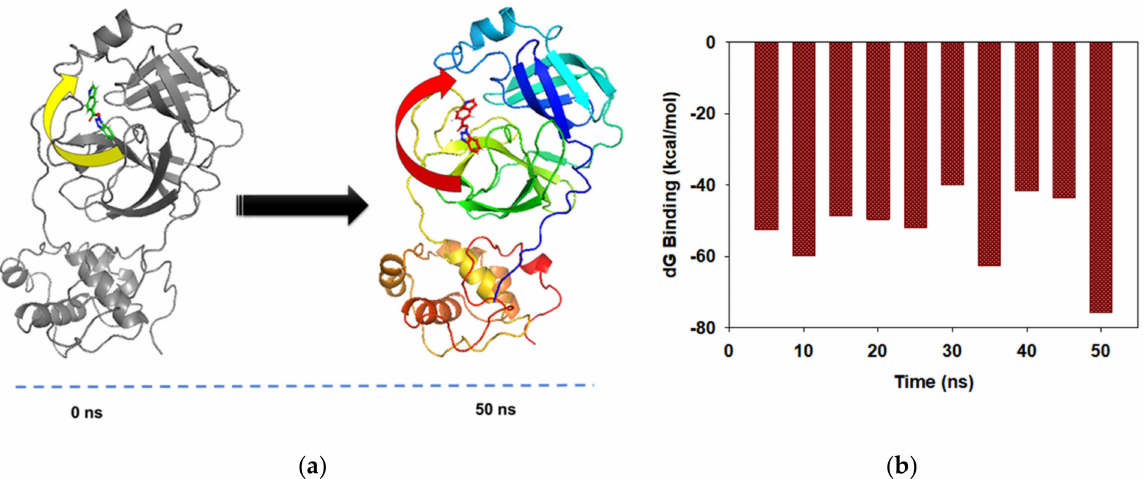
Figure 5. ( a ) Structural superimposition of first frame (0 ns) and last frame (50 ns) of 1 bound Mpro complex after simulation. The conformational change of secondary structure (arrow) observed at the 1 bound site and geometry of ligand displayed at 0 ns (yellow) and 50 ns (red). ( b ) Free-energy decomposition of binding energies at every 5.0 ns frame in MMGBSA calculations for 50 ns